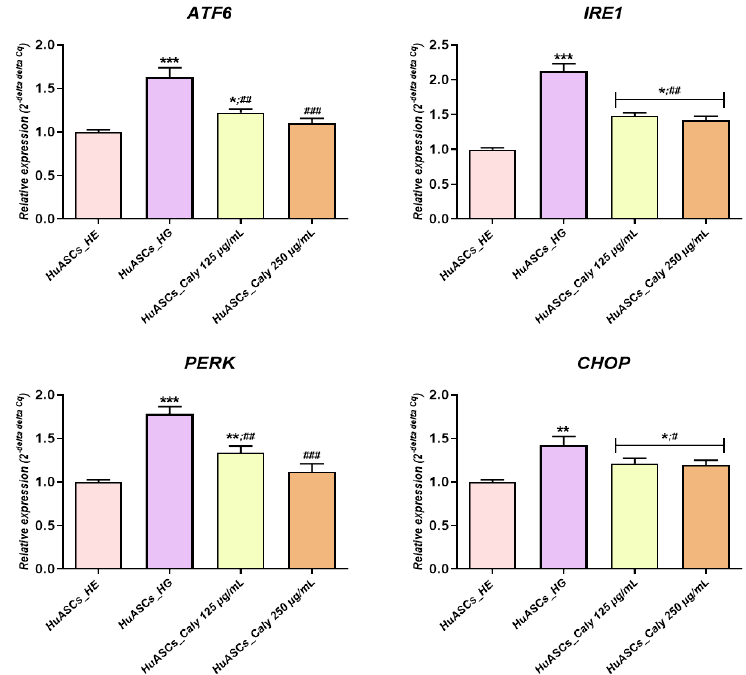
Figure 6. Preventive effect of total calystegines extract on ER stress engagement in HuASCs cells cultured in a hyperglycaemic milieu. Relative gene expression of ER stress master sensors and effectors. Representative data from three independent experiments are shown ± SD (n = 3). An asterisk (*) indicates a comparison of the HG group to the untreated healthy cells. A hashtag (#) indicates a comparison of the HG group pre-treated with calystegines to the HG untreated healthy cells. */# p < 0.05, **/## p < 0.01, ***/### p < 0.001. HuASCs_HE: human ASCs healthy untreated cells; HuASCs_HG: hyperglycaemic human ASCs cells exposed to a high concentration of glucose. HuASCs_Caly 125 µg/mL: hyperglycaemic human ASCs cells pre-treated with 125 µg /mL calys- tegines extracted and exposed to a high concentration of glucose. HuASCs_Caly 250 µg/mL: hyperglycaemic human ASCs cells pre-treated with 250 µg /mL calystegines extracted and exposed to a high concentration of glucose.